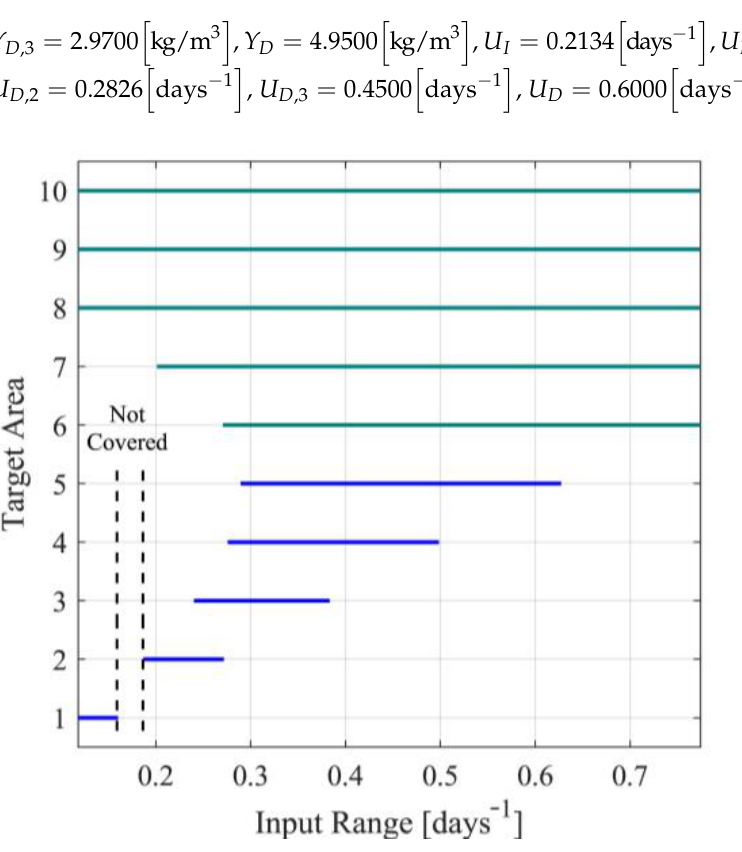
Figure 3. Target operating areas. In Figure 4a,b, the responses of the nonlinear system and the switching observer scheme are presented. In Figures S8 and S9 of Supplementary Material the respective estimation errors are presented. From Figure 4a, it is observed that the estimation of the substrate concentration is visually identical to the respective nonlinear model response, presenting minimal estimation error (see Figure S8 of the Supplementary Material). Regard- ing the estimation of the microorganism concentration (see Figure 4b and Figure S9 of the Supplementary Material), the estimation is near the respective model response, presenting acceptable estimation error.